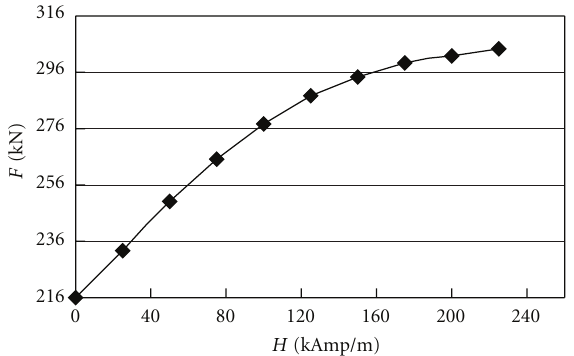
Figure 8: Squeezing force versus magnetic field